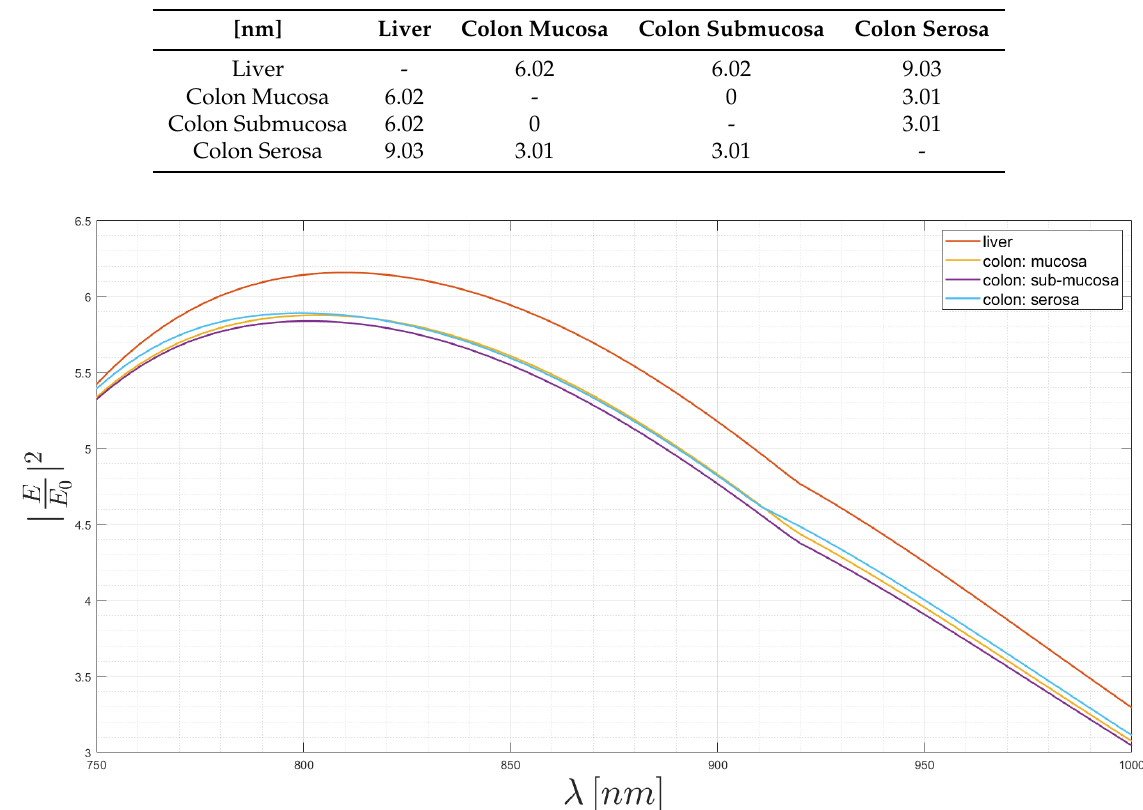
Figure 18. Gold nanostructure response for different human body tissues (zoomed).